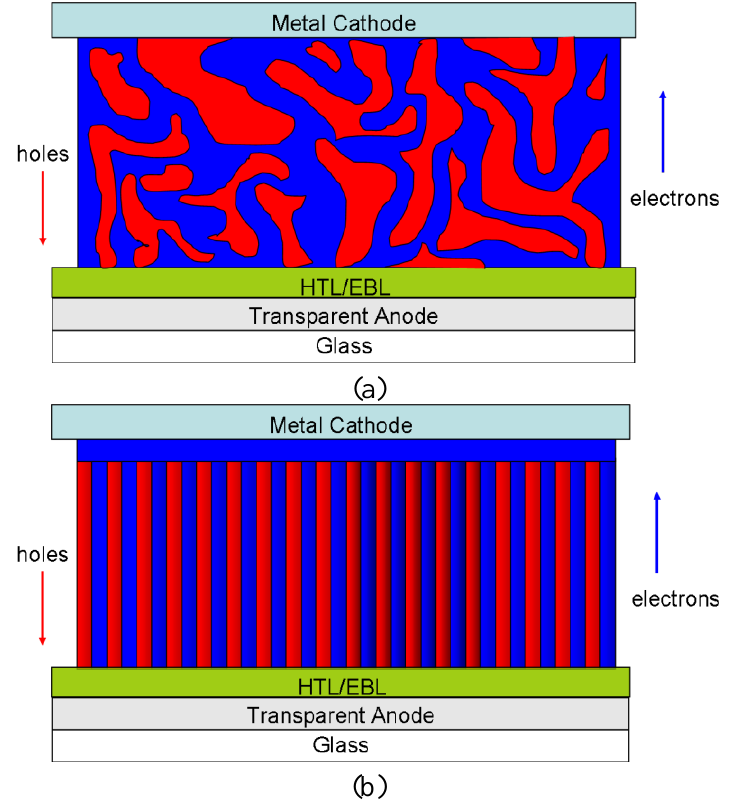
Figure 4. (a) Commonly depicted morphology of a bulk heterojunction OPV cell with disordered and discontinuous charge transport networks. Blue: acceptor domains. Red: donor domains. (b) Commonly proposed ideal morphology for an OPV cell. Blue: acceptor domains. Red: donor domains. The width of each domain is comparable to the exciton diffusion length and the active layer thickness is sufficient to absorb the incident